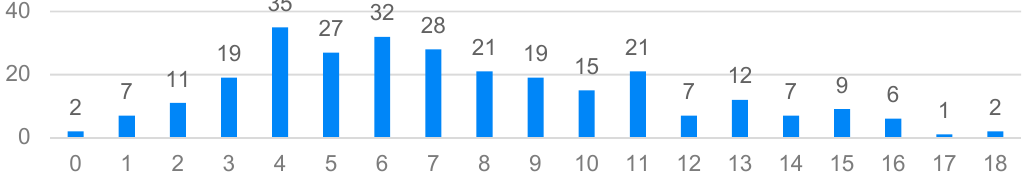
Figure 1. Distribution of the Hospital Anxiety and Depression Scale (HADS) anxiety scores.